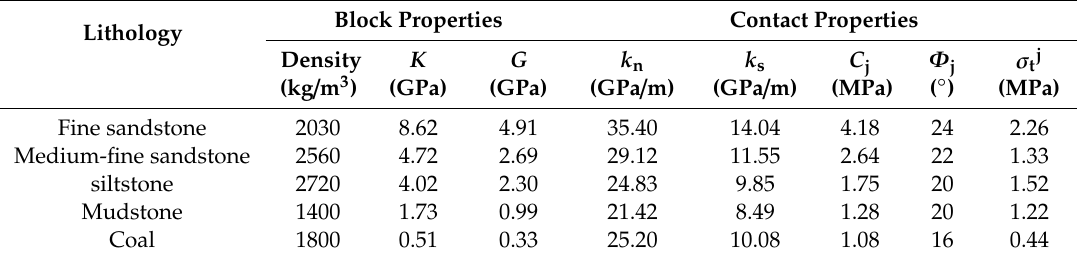
Figure 11. Simulated compression tests and stress–strain curves of the rock mass. Table 5. Micromechanical parameters of rock mass used in the UDEC model.